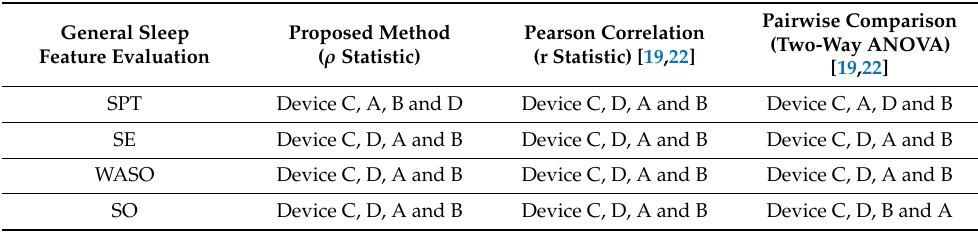
Table 9. Comparison among different evaluation methods and the proposed method on evaluating the general sleep features with the ranking according to the accuracy with PSG.